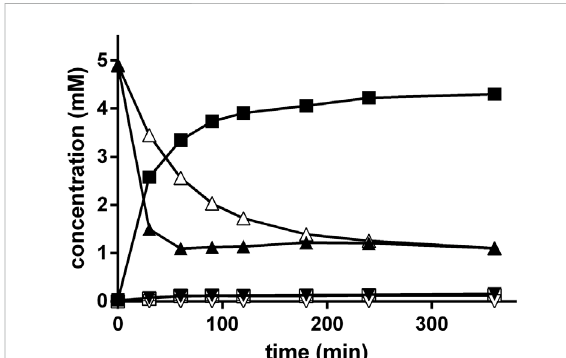
FIGURE 11 Chemoenzymatic synthesis of ( R )-PGA using a combination of a chemical Strecker synthesis and hydrolysis of theformedPGN with E. coli JM109 Δ pepA (pIK9/pap). The reaction mixture (1 ml) contained in 2 ml glass vessels 100 mM benzaldehyde and 300 mM KCN in 500 mM NH 4 -acetate/NH 4 OH (pH 9.5). It was mixed at 40 ° C with a small stirring bars at about 1,500 rpm. The Strecker synthesis was started by the addition of benzaldehyde. After the completion of the chemical step (120 min), the biotransformation reaction was initiated by the addition of the cell suspension (55 μ l, resulting in an OD 600nm = 5 in the experiment). Aliquots (10 μ l each) were removed after different times and the reactions stopped by adding 90 μ l of methanol/water/1 M HCl (5: 3:2 v/v/v). The cells were removed by centrifugation (20,000 g